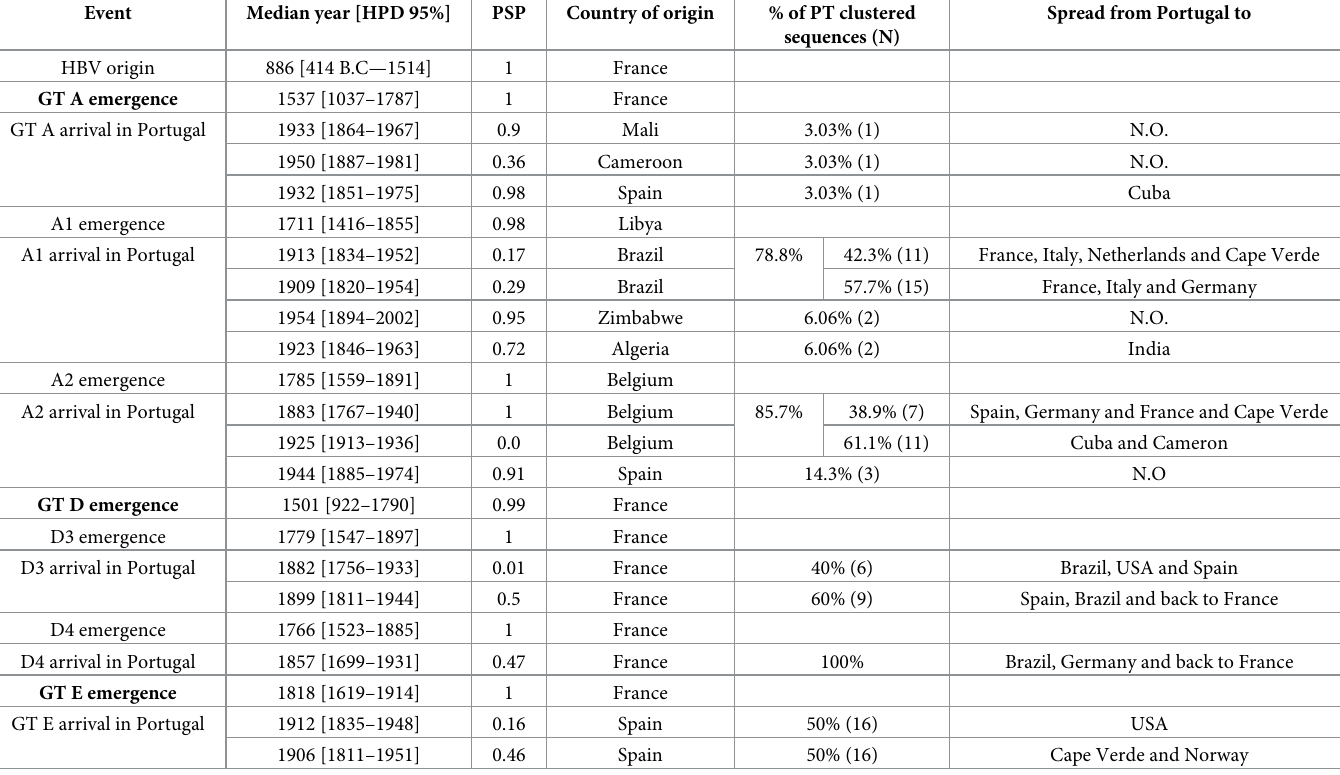
Table 3. Estimated time and place of HBV origin, origin of the Portuguese strains, time of introduction in Portugal and role of Portugal in the global HBV spread.